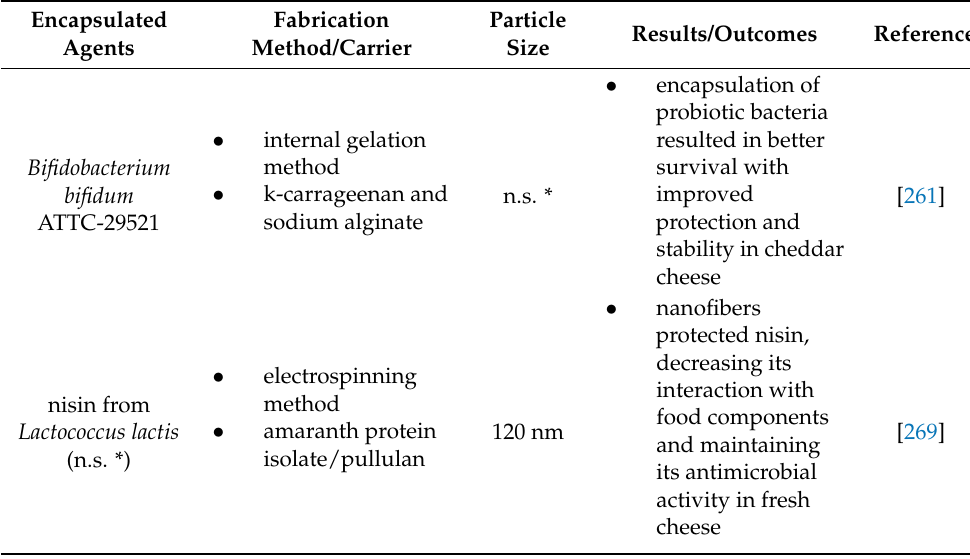
Table 6. Most recent examples of the encapsulation of various active agents (functional components) to aid in cheese production and increase its bioactive value and